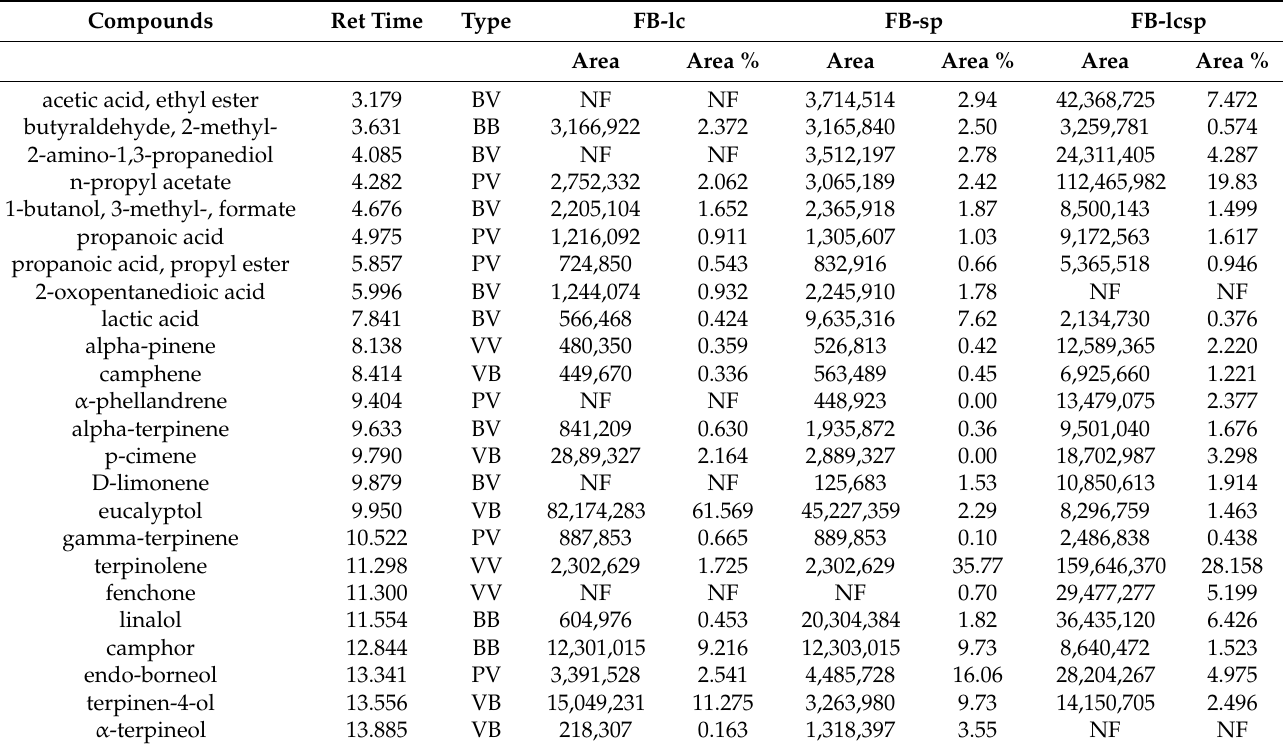
Table 3. Aromatic compounds identified from fermented beverage extracts of by GC–MS head